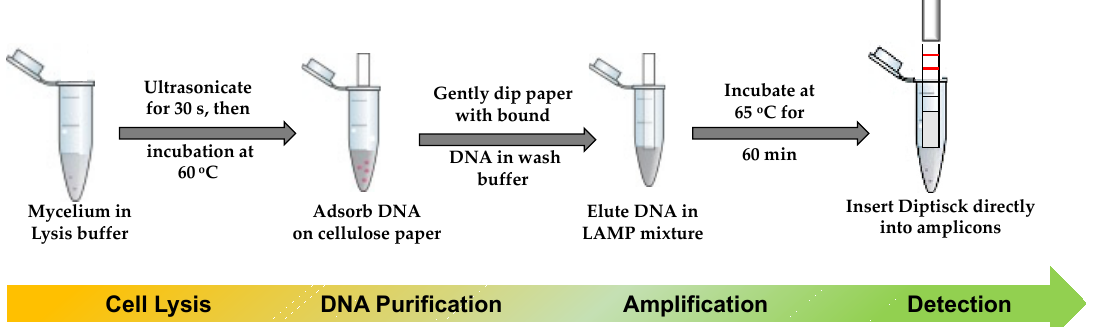
Figure 7. Summary diagram of a complete detection of C. gloeosporioides for on-farm use. The pro- posed methodology involving the solid-phase of nucleic acid extraction, an isothermal amplification, and the visual detection of the pathogen in just 5 quick steps. This protocol can be adaptable to different point-of-need uses and scalable to other pathogens.